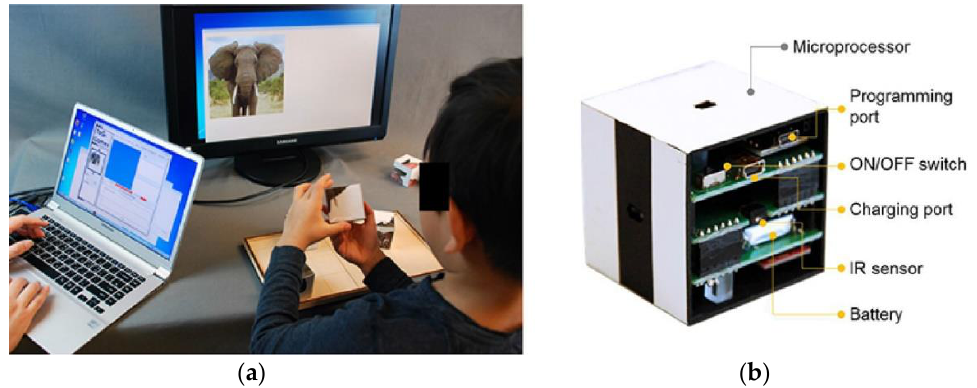
Figure 17. Child using SIG-Blocks with segmented animal faces to match the displayed image and an adult observes the cognitive skills in the graphical user interface (GUI) ( a ), Hardware design of SIG-Block for TAG-Games ( b )